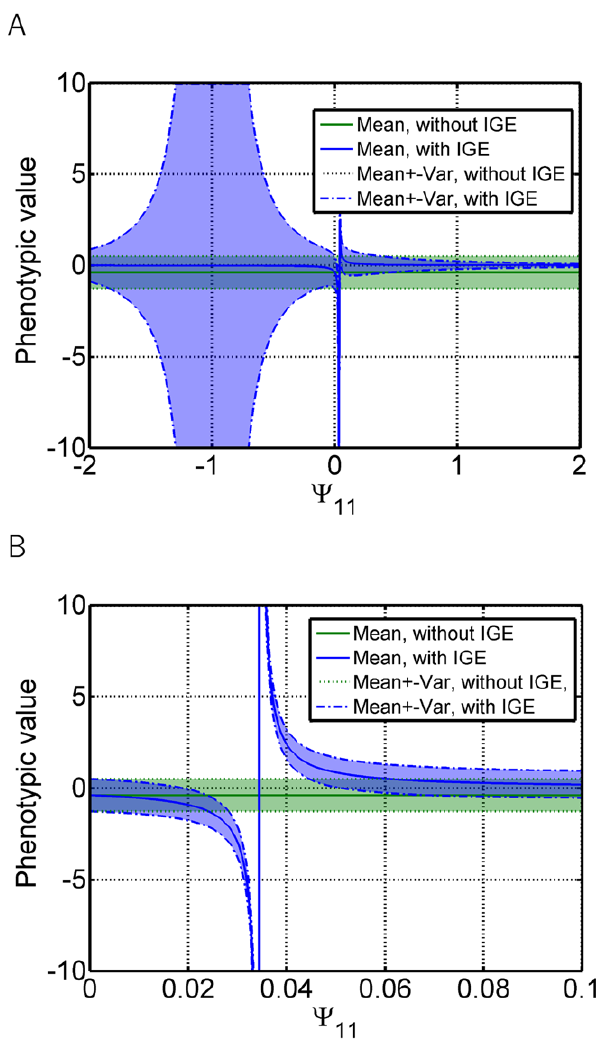
Figure 5. Interactions with feedback at the trait level - mean and variance. Dependence of the mean group phenotypic value and its variance on the interaction strength Y 11 , when one trait affects itself in other individuals (as depicted in Figure 1 C). Mean and variance (A) around det ( I z Y ) ~ 0 , (B) around det ( I { N Y z Y ) ~ 0 . Blue - mean phenotype and its variance if IGEs are considered. Green - no IGEs are considered. Simulation of 30 interacting individuals.